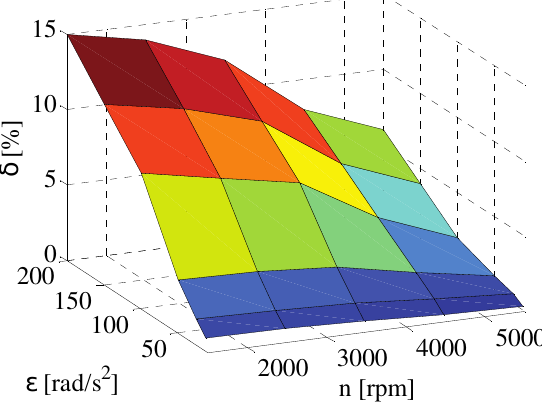
Fig. 9. Error δ in function of engine speed n and angular acceleration ε for throttle opening 90º Fig. 10 shows similar situation but in this case throttle angle is only 30º. Maximum difference is for crankshaft angular acceleration of 200 rad/s 2 and equals 10%. It means that the difference δ decreases with decreasing throttle opening and is the largest at full throttle operation.